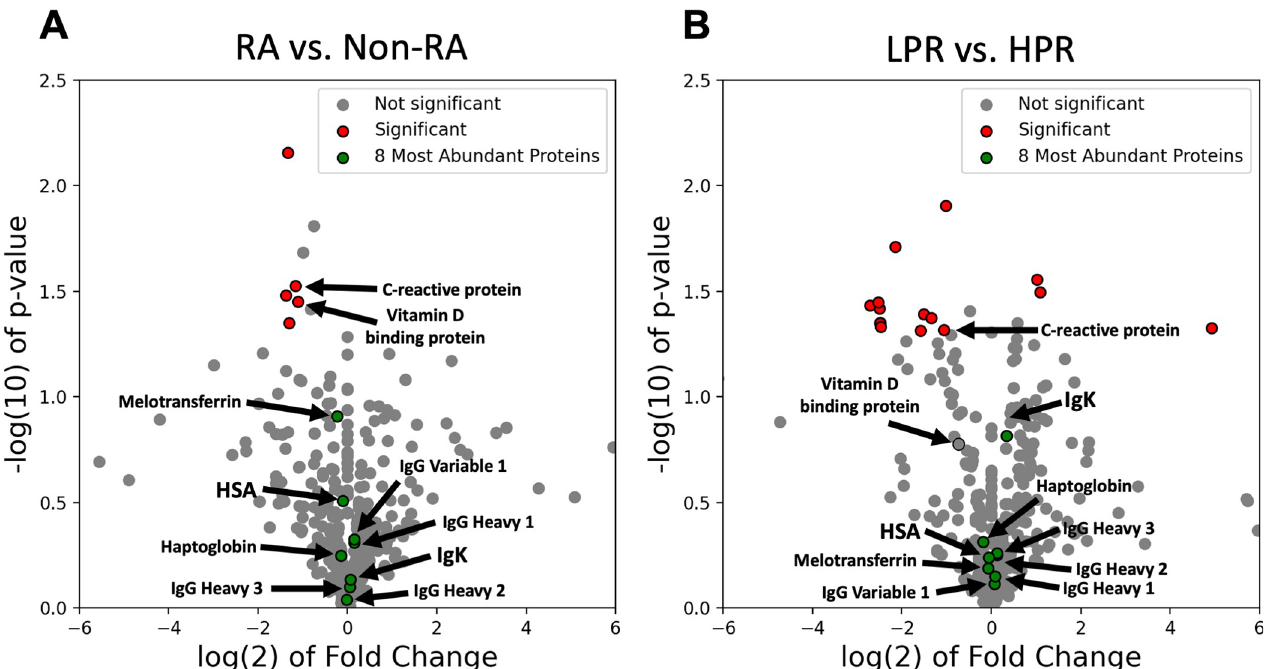
Fig 4. Protein concentration differences in RA. Volcano plots indicating the fold change and p-value for all 421 detected proteins, comparing A) RA/Non-RA samples and (B) LPR/HPR samples. The top eight most abundant proteins are indicated in green (all insignificant), and the statistically significant proteins (-1 > log2(fold change) > 1, p-value < 0.05) are indicated in red. C-reactive protein is the only significant protein in both plots. The fold change is calculated in each comparison by dividing RA abundance by non-RA abundance and LPR abundance by HPR abundance for all proteins that were detected in all